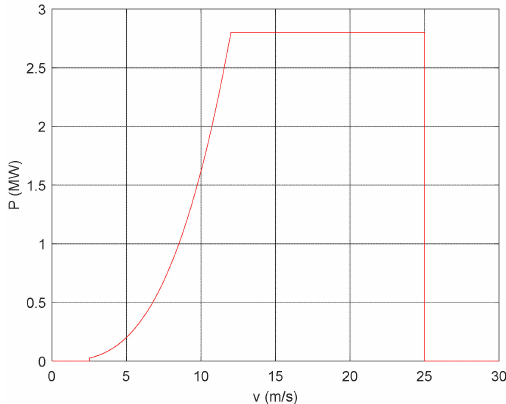
Figure 7. The dependence of output power of wind generator on wind speed.